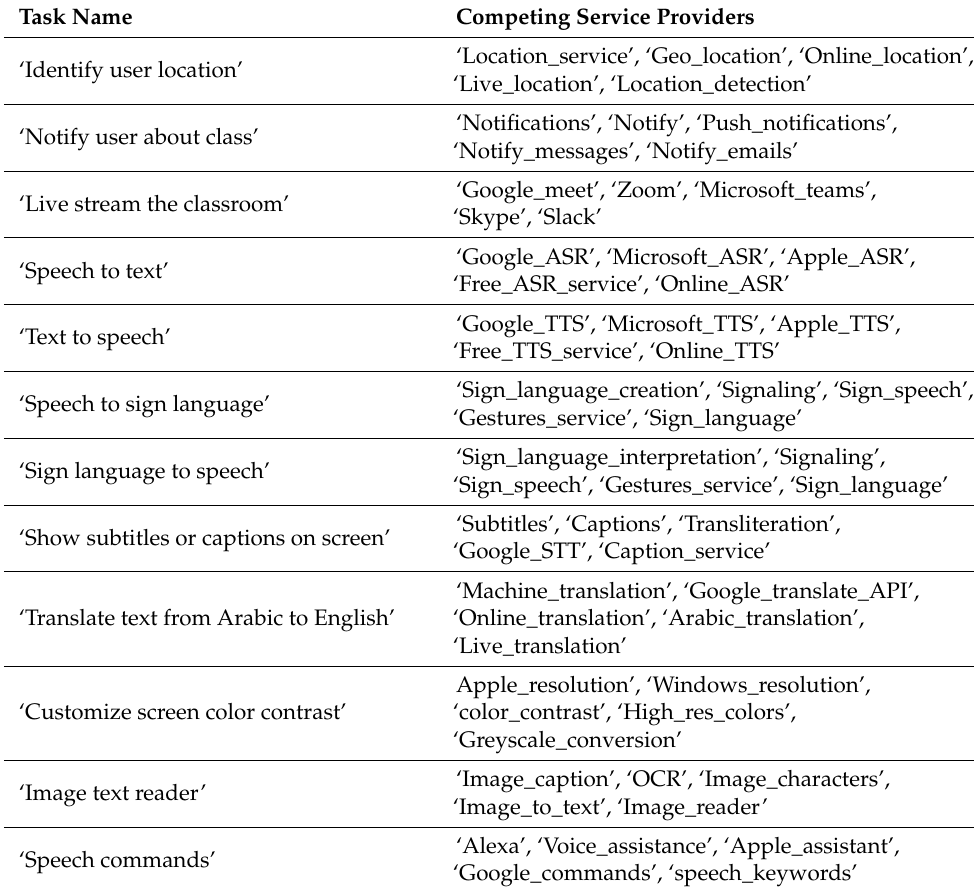
Table 5. Service providers for each online learning